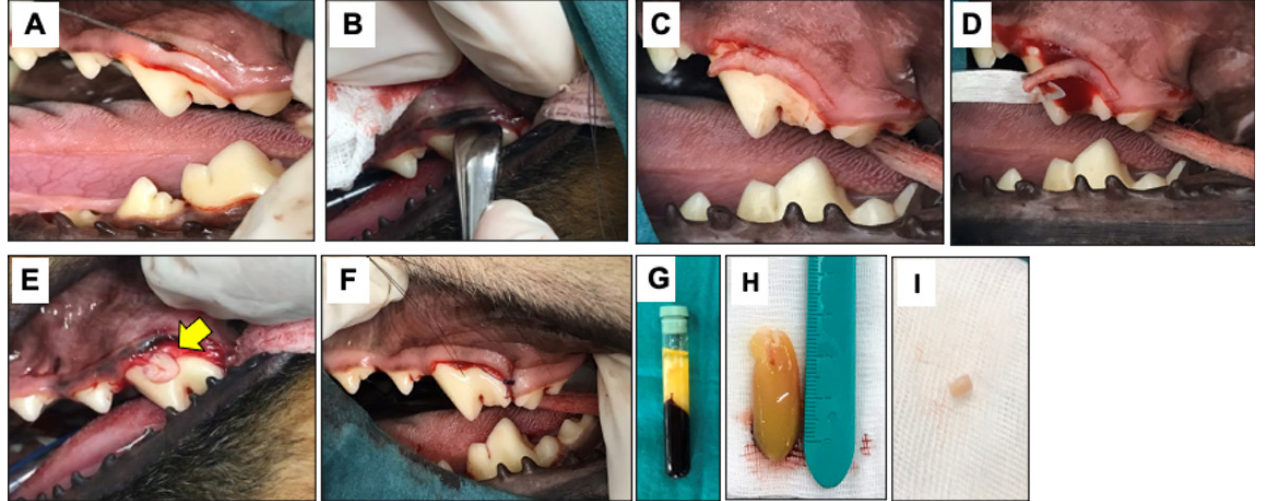
Figure 1. Surgical procedures. The modified Widman flap technique (MWF) is illustrated. An reverse bevel incision was performed ( A ), and subsequently full thickness mobilized mucoperiosteal flap was reflected ( B ). An intrasulcular incision ( C ) and horizontal incision ( D ) were performed. For the OFD+bPRF group, bubaline blood-derived PRF (bPRF) was placed over the defects after open flap ( E ). Yellow arrow indicates bPRF. The surgical area was closed with a simple interdental suture ( F ). bPRF was prepared from fresh blood samples. Blood was collected from Thai buffalo cephalic vein and centrifuged immediately at 3000 rpm for 10 min ( G ). bPRF clot was harvested from between upper layer (acellular plasma) and bottom layer (red corpuscles) ( H ). The bPRF membranes were cut with a biopsy punch to create round pieces with a 6 mm diameter ( I ). OFD; open-flap debridement-treated group, OFD+bPRF; open-flap debridement and bubaline blood-derived platelet-rich fibrin-treated group.